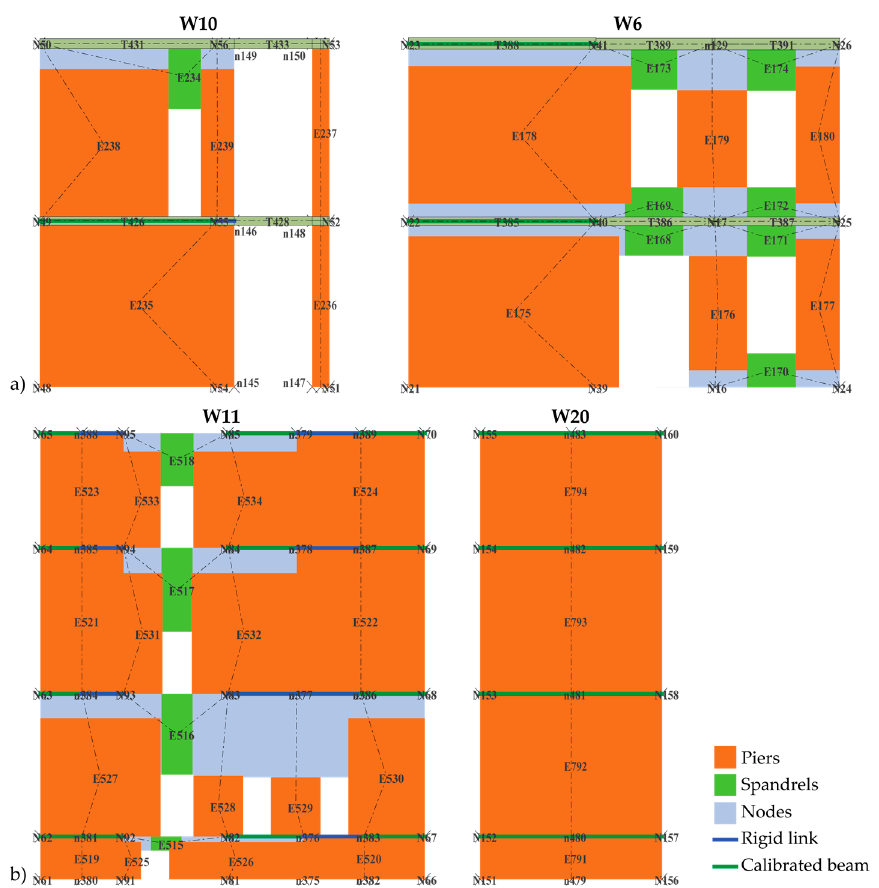
Figure 20. Examples of equivalent frame idealization for some walls of numerical models of Pizzoli town hall ( a ) and the former courthouse of Fabriano ( b ) (the walls are those marked in Figure 19).